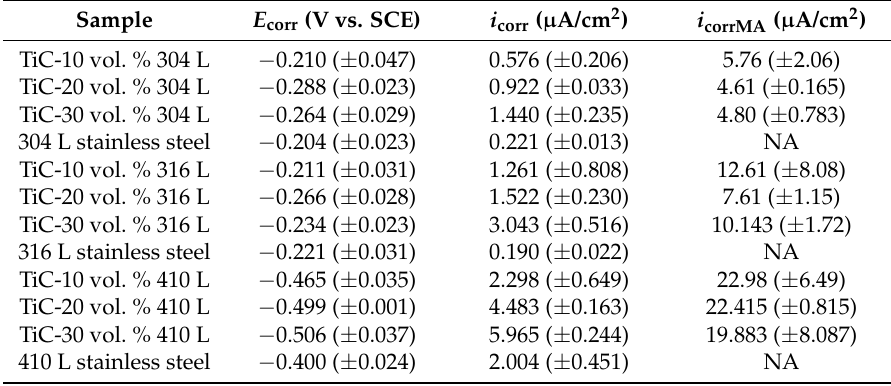
Table 4. The Tafel-derived values of i corr and E corr determined for the cermets and baseline steels. The presented values are the mean for four repetitions (standard deviation values are shown in parentheses). The values for i corrMA are determined by assuming only the metallic phase component contributes to the exposed corrosion area, following the methodology proposed by Hochstrasser-Kurz